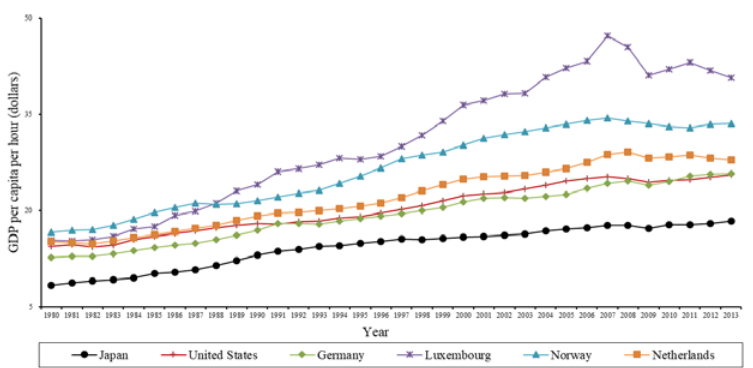
Figure 2: Comparison of GDPpp in six countries